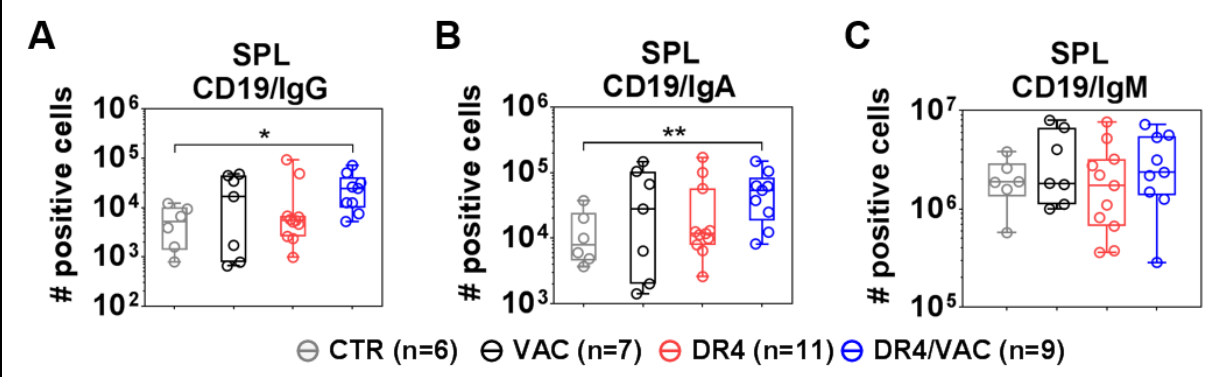
Figure 10. VAC and DR4/VAC promotes B cell maturation and response. (A – C) Terminal analyses of of absolute numbers (#) of positive cells identified as CD19 + IgM − IgG + , CD19 + IgM − IgA +, and CD19 + IgM + B cell subsets in the spleen by flow cytometry. Data pooled from four independent experiments. * p < 0.05, ** p < 0.01. Statistical analyses were performed using the Welch t -test applied to log data with Laplace correction (+1) (unpaired).